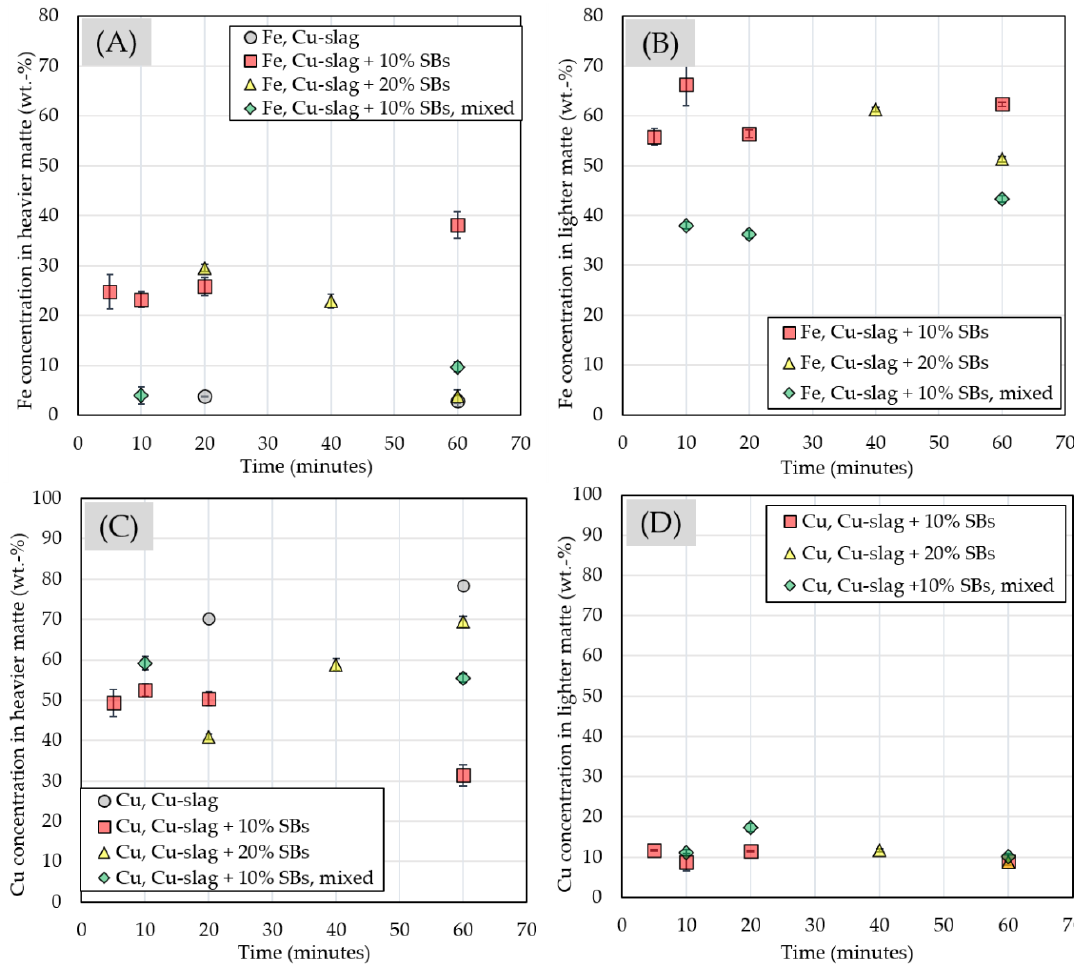
Figure 15. Concentrations of Fe ( A , B ) and Cu ( C , D ) in heavier ( A , C ) and lighter ( B , D ) matte phase as a function of contact